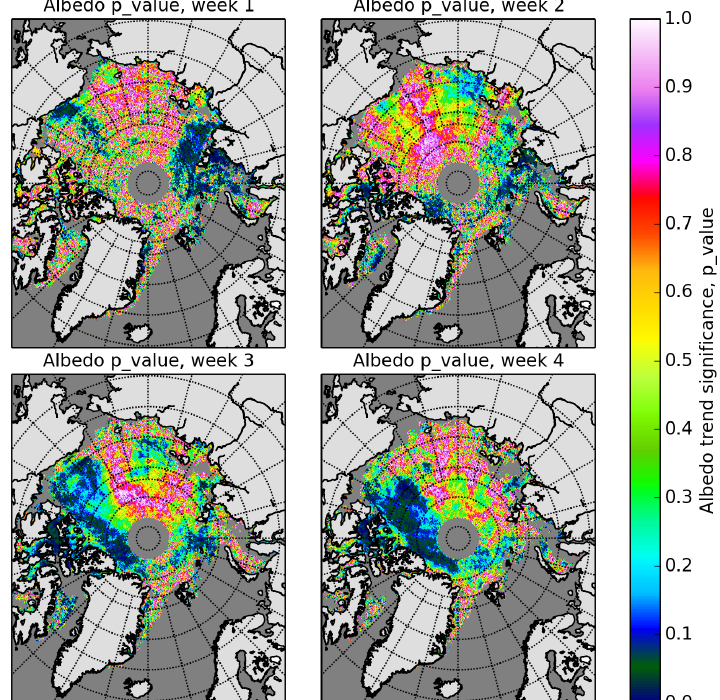
Figure 12. P values for the weekly broadband albedo trends (see Fig.